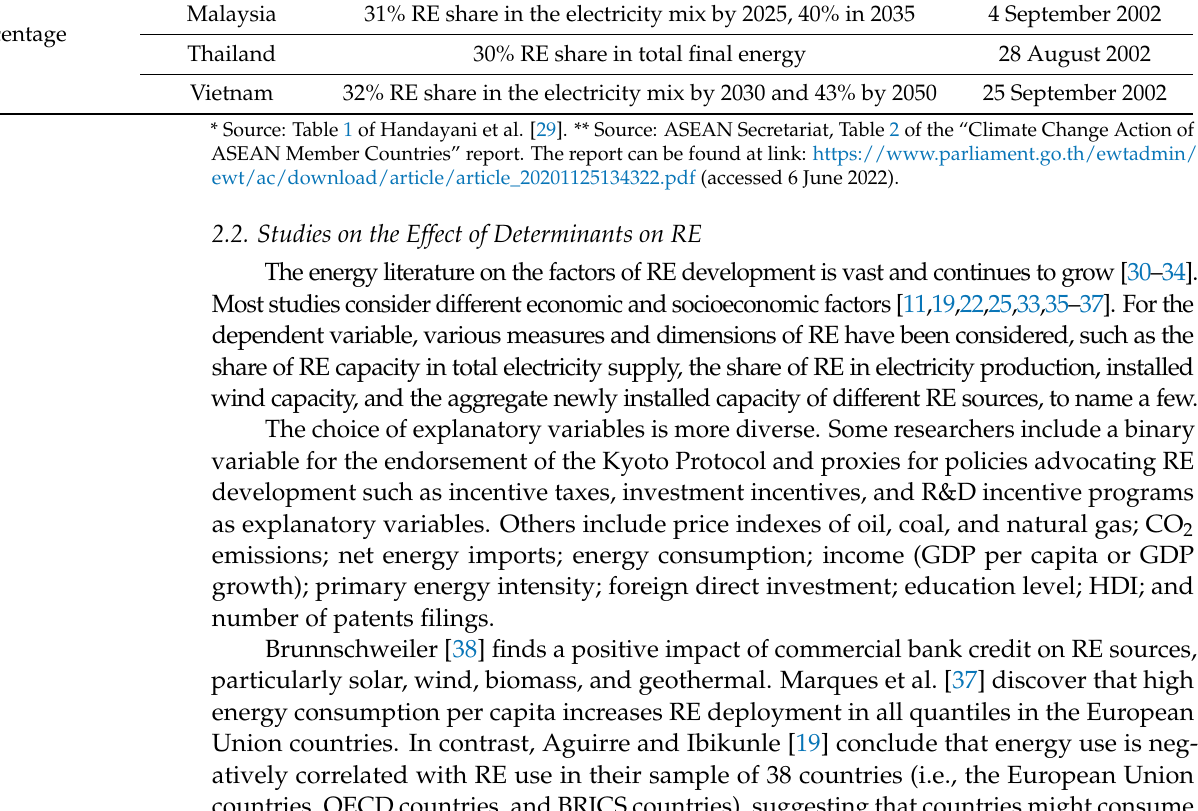
* Source: Table 1 of Handayani et al. [29]. ** Source: ASEAN Secretariat, Table 2 of the “Climate Change Action of ASEAN Member Countries” report. The report can be found at link: